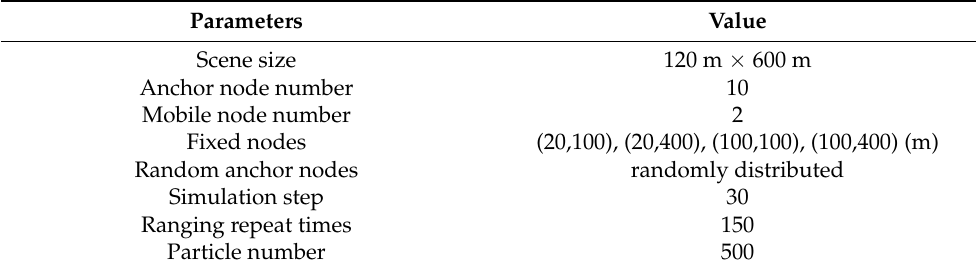
Table 2. Experimental parameters and